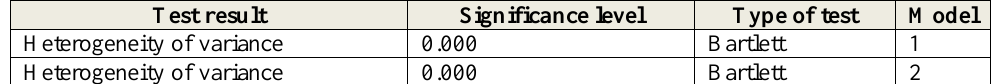
Table 10: Model error homogeneity of variance